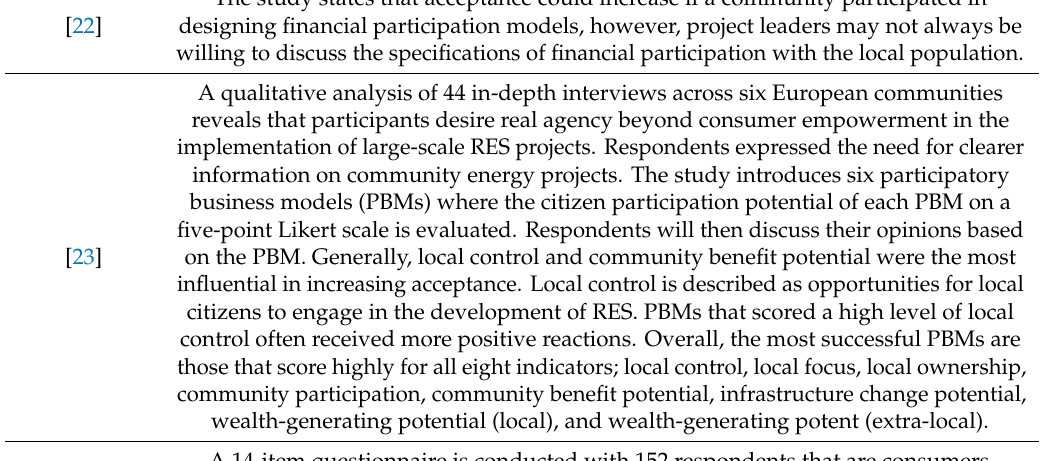
Table 2. Varying results and opinion of trust in governance and procedural justice on social acceptance.